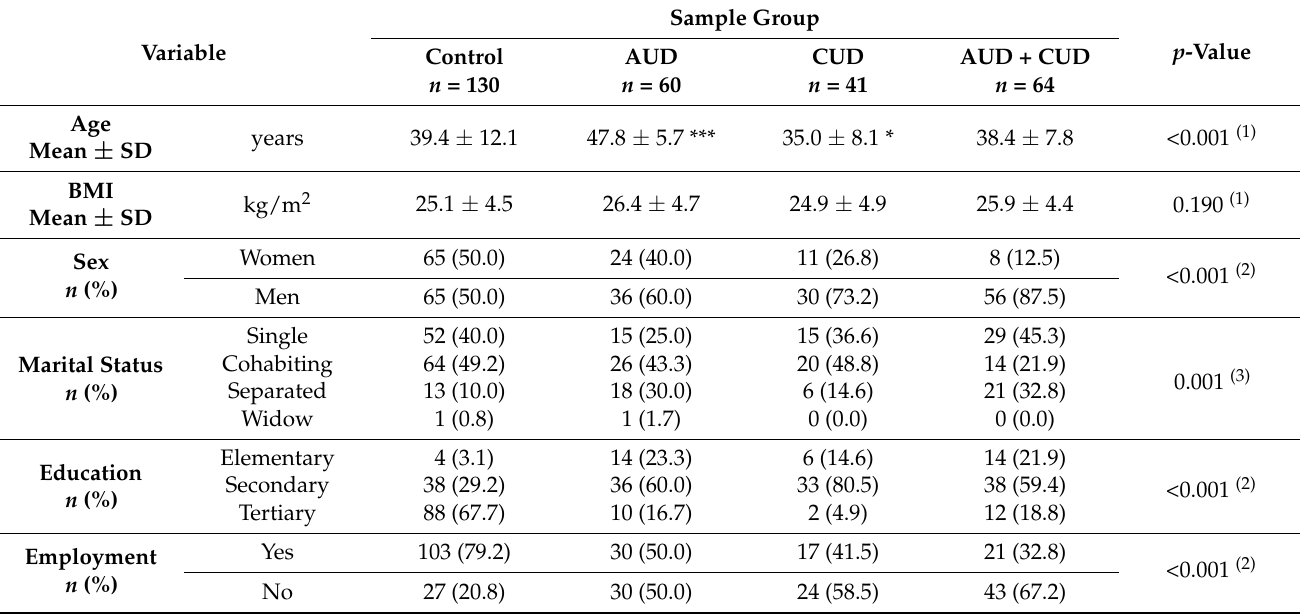
Table 1. Sociodemographic